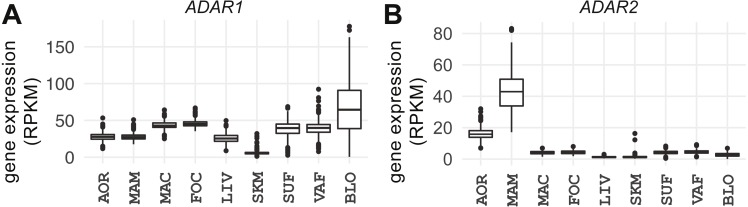
Expression of ADAR1 and ADAR2 across studied tissues.Box plots show gene expression of (A) ADAR1 and (B) ADAR2 in RPKM (y-axis). AOR, aorta; MAM, internal mammary artery; MAC, macrophage; FOC, foam cell; LIV, liver; SKM, skeletal muscle; SUF, subcutaneous fat; VAF, visceral fat; BLO, whole blood.